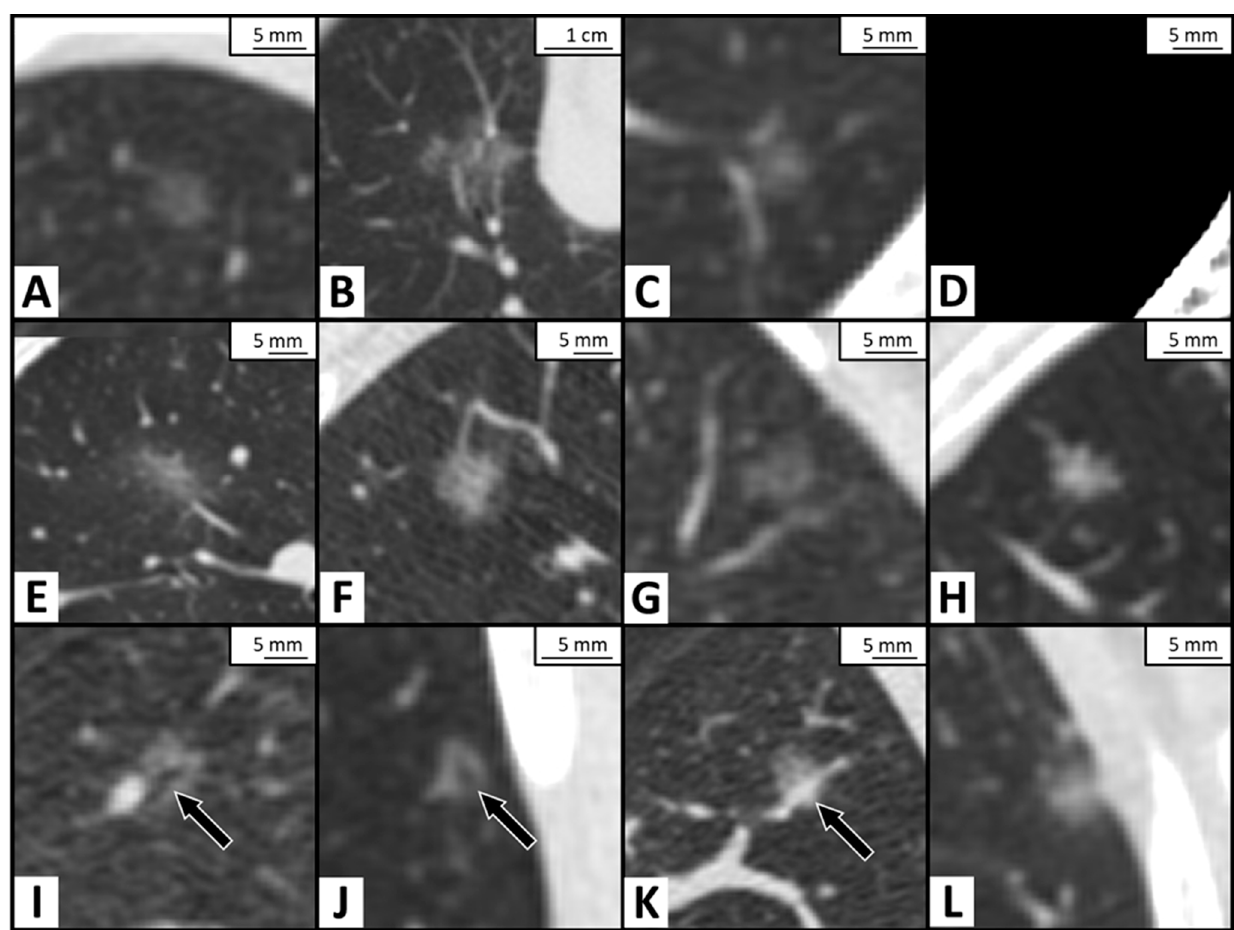
Figure 2. The illustration of imaging characteristic of the pure ground-glass nodule (pGGN) on computed tomography images. ( A ) Atypical adenomatous hyperplasia (AAH) with homogenous content, oval shape, well-defined interface, and smooth margin. ( B ) Minimally invasive adenocarcinoma (MIA) with irregular shape and vessel passing through. ( C , D ) Invasive adenocarcinoma (IA) with heterogeneous content, showing suspicious solid component in the center of nodule in lung window (window width/window level = 1500 HU/ − 600 HU) in C but invisible in mediastinal window (window width/window level = 350 HU/50 HU) in D. ( E ) Necrotizing granulomatous inflammation with the ill-defined interface. ( F ) IA with coarse margin and polygonal in shape. ( G ) IA with lobulation. ( H ) MIA with spiculation. ( I ) IA adjacent to a vessel with air-bronchogram (black arrow) in the nodule. ( J ) IA with vacuole sign (black arrow). ( K ) IA with type II vessel relationship, dilated vessel (black arrow) within the nodule. ( L ) Adenocarcinoma in situ with pleural retraction.